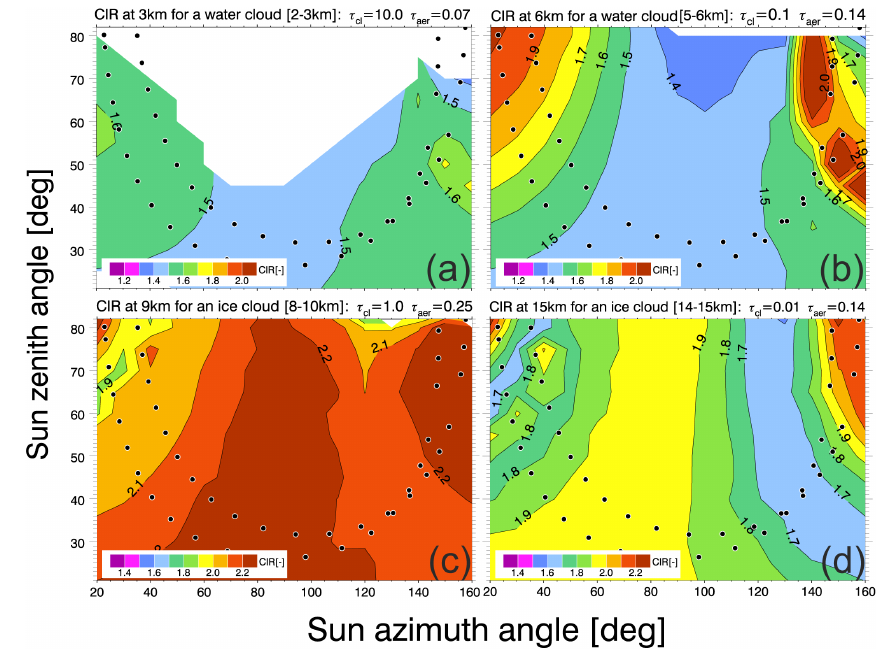
Figure 6. Simulated colour index ratios as a function of sun zenith angle and sun azimuth angle for different cloud layer heights. The radiances are calculated using the SCIATRAN forward model. The CIR are retrieved on a 3km height grid. The black and white dots depict zenith and azimuth angle pairs for a typical SCIAMACHY orbit. Small azimuth angles correspond to the Northern Hemisphere and large values to the Southern Hemisphere. Please note the different colour scales for water and ice